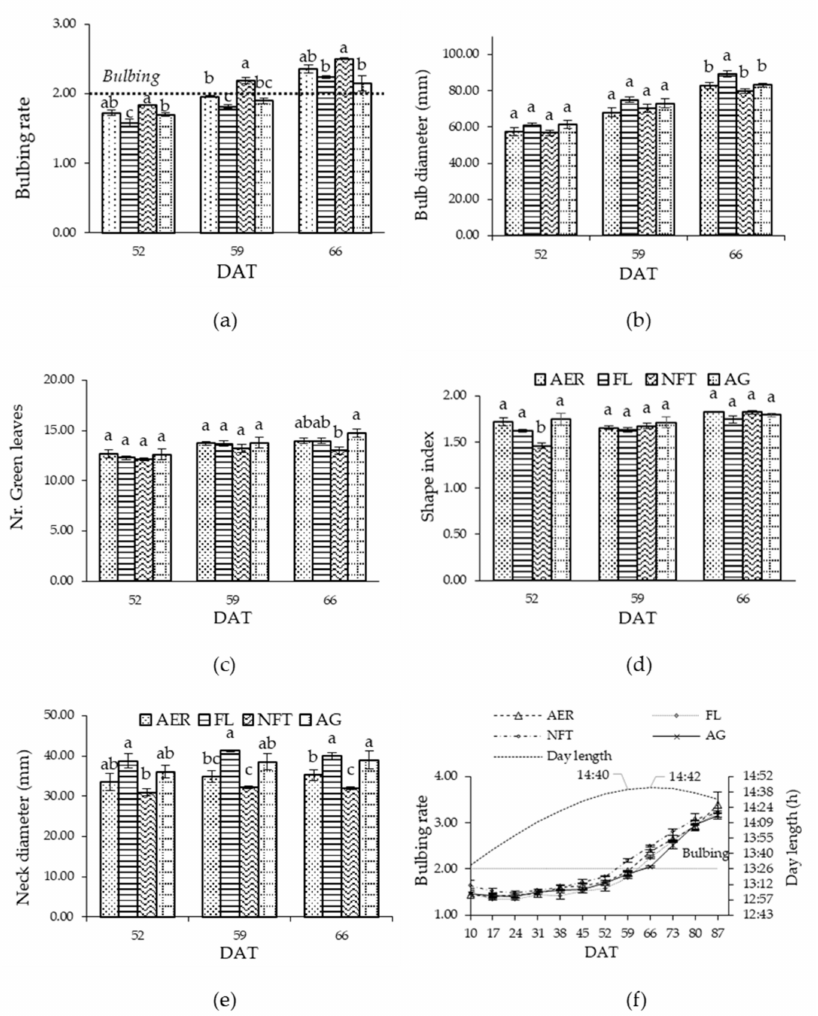
Figure 4. Impact of the CSCS on: ( a ) the bulbing rate described as the quotient of the bulb to minimum sheath diameter ≥ 2; ( b ) the bulb diameter (mm); ( c ) number of green leaves; ( d ) the shape index; ( e ) the neck diameter at the 52nd, 59th, and 66th DAT; ( f ) bulbing rate against time; (days) and day length for the trial location. Vertical bars indicate ± standard errors of means of ten (10) measurements per replicate. Similar letters indicate non-significant differences at p ≤